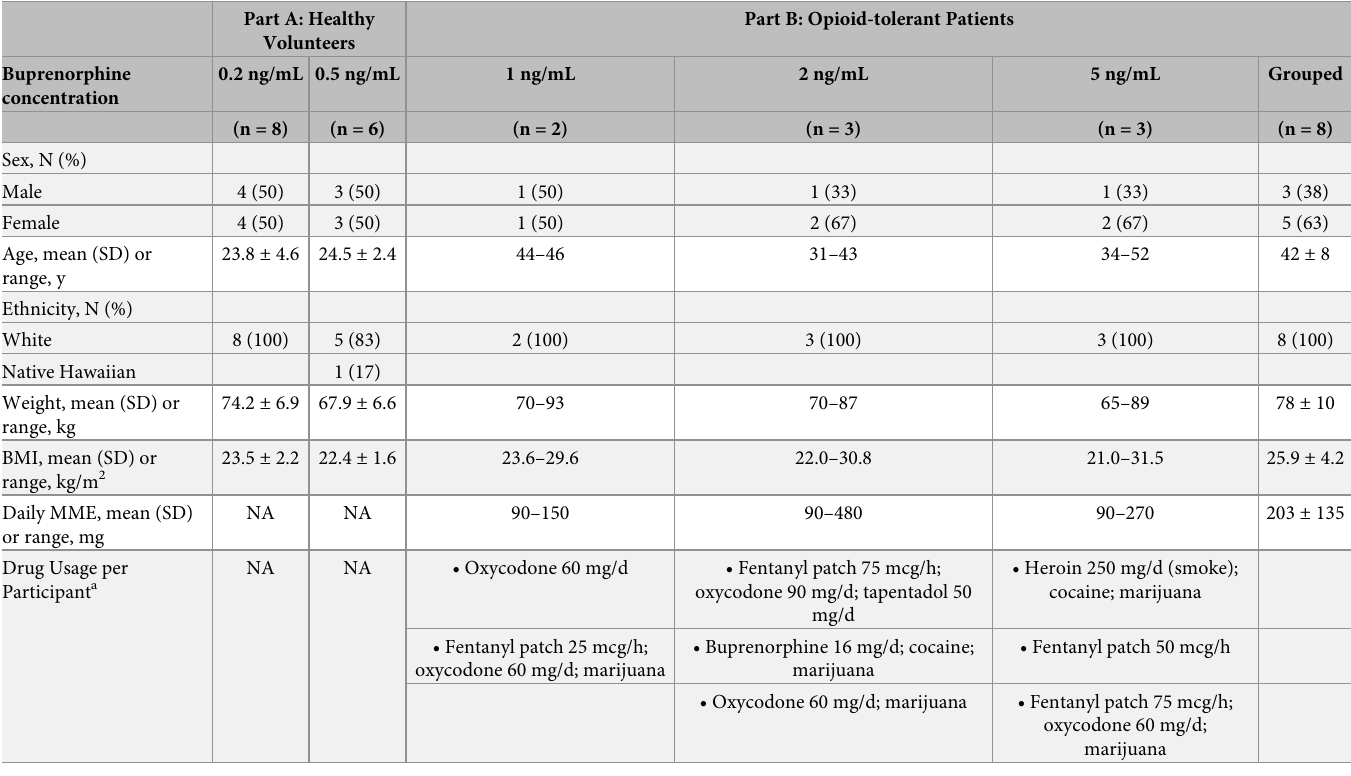
Table 1. Participant demographic and clinical